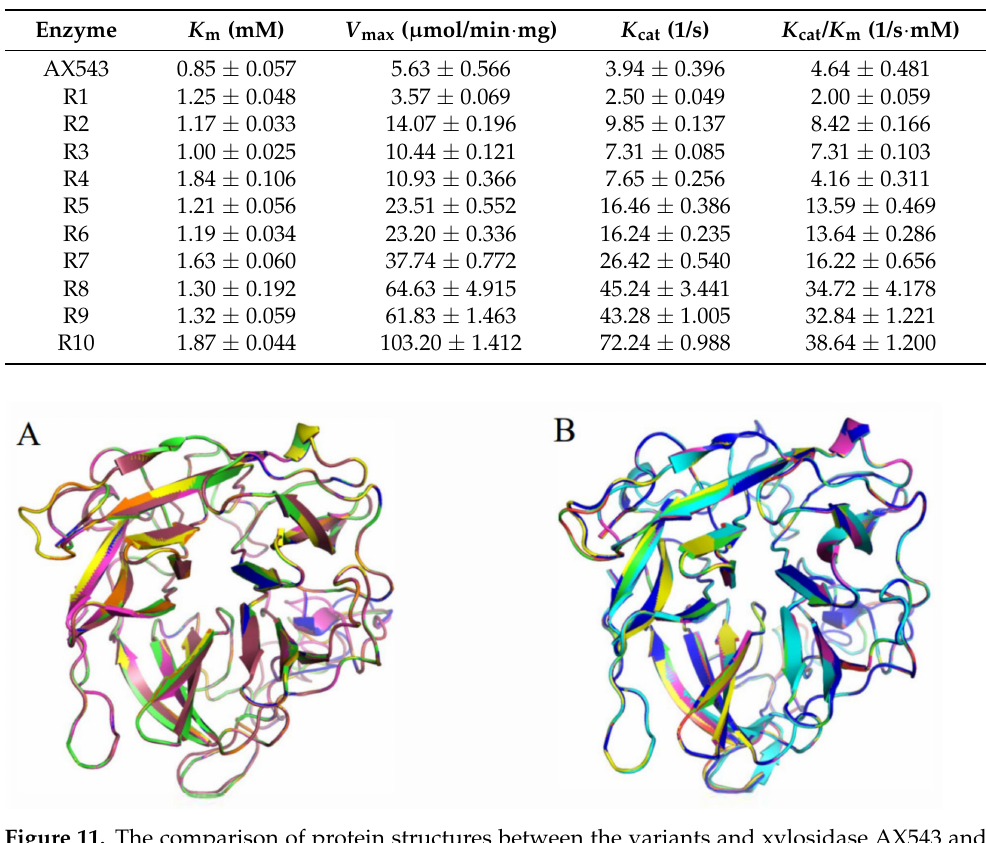
Table 4. The kinetic parameters of AX543 and its chimeras.